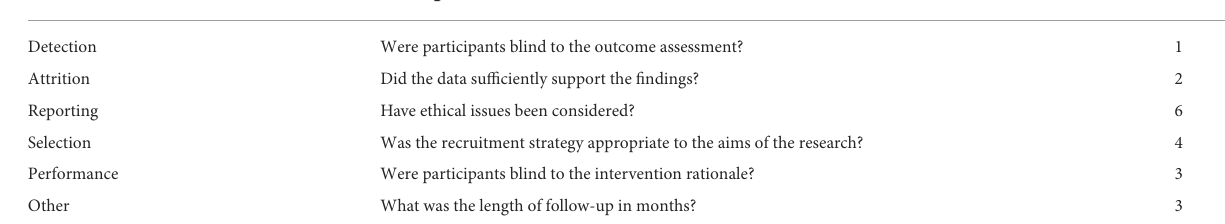
TABLE 6 Example items from the risk of bias tool.